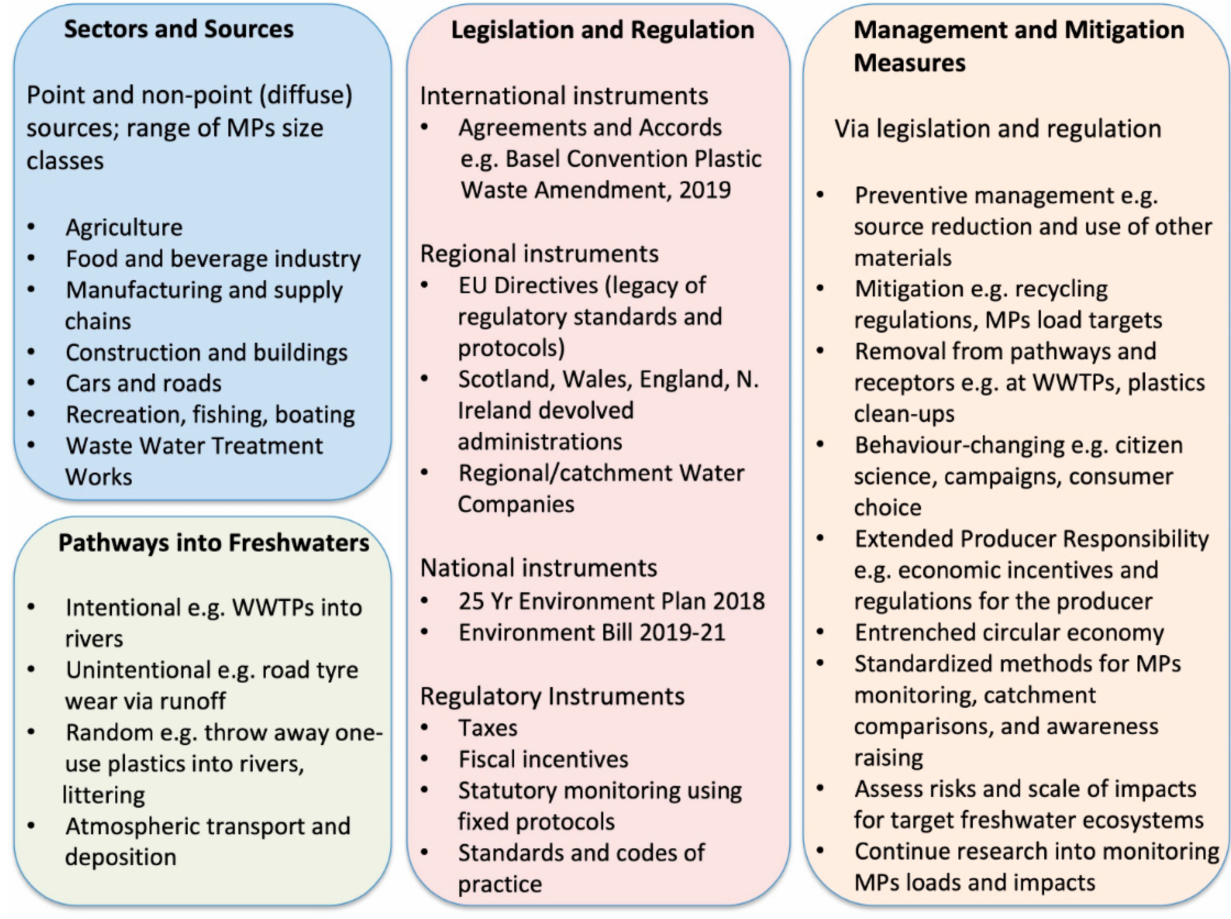
Figure 6. Microplastic sources, pathways, legislation and mitigation